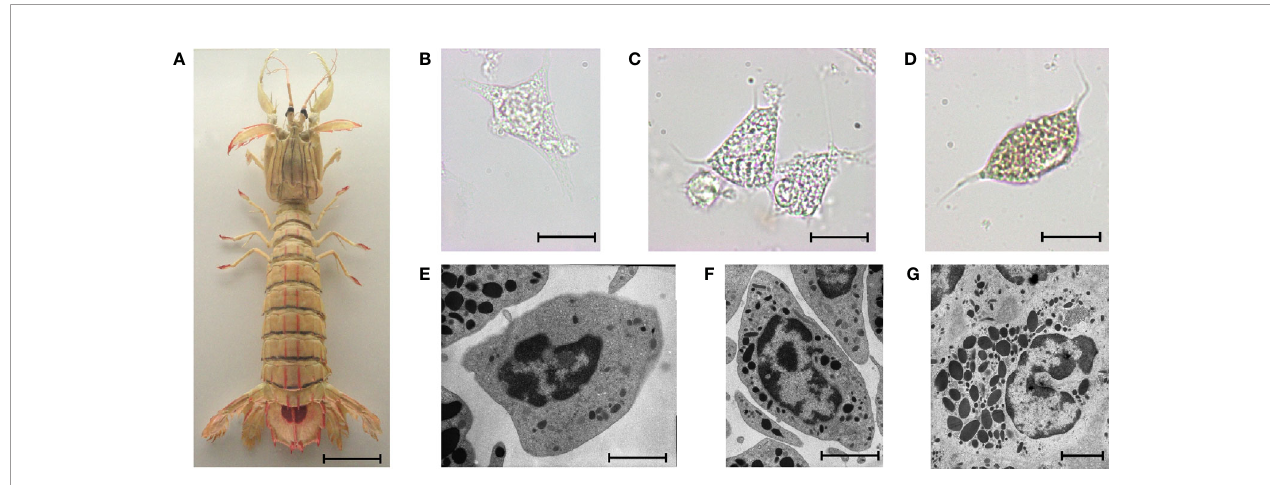
FIGURE 3 | The mantis shrimp Squilla mantis (A) , an edible stomatopod crustacean, common along the European coasts, and its hemocytes. (B – D) : light microscopy; (E – G) : transmission electron microscopy; scale bar: 3 cm for (A) ; 5 µm for (B – D) ; 2 µm for (E – G) , (B, E) : hyaline cells; (C, F) : semigranulocytes; (D, G) :